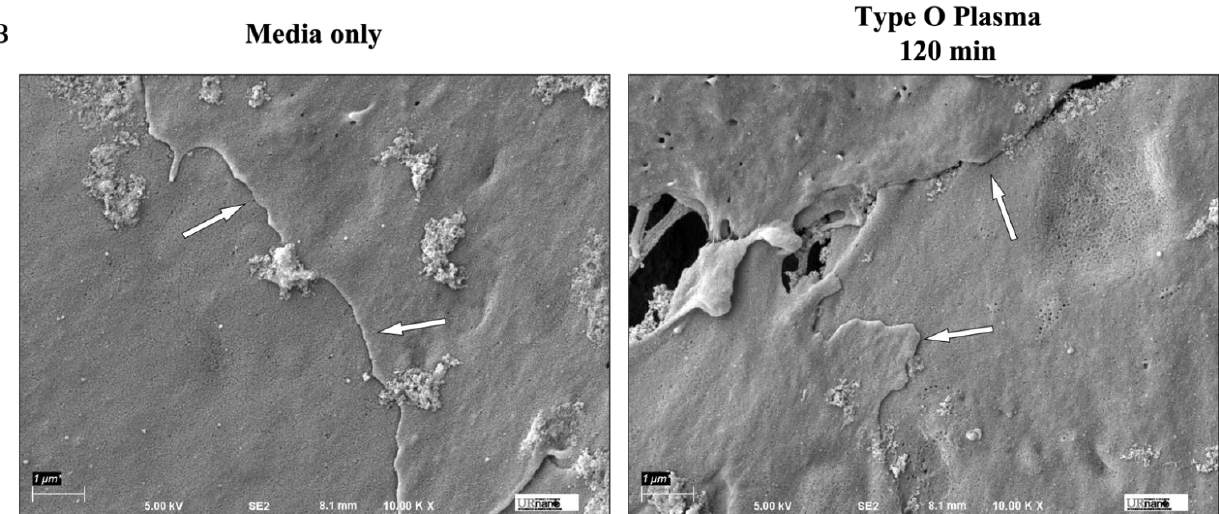
Figure 3. HPAEC cell–cell adhesion damaged by IC treatment. Type O HPAEC visualized by Scanning Electron Microscopy (SEM) after injury. ( A ) Cells were treated with non-concentrated or concentrated plasma-derived IC at 1:1 concentration with media for the indicated time points and imaged at different magnifications. Scale bar: 10,000 × : 1 µ m; 5000 × : 2 µ m; 1500 × : 7 µ m; 500 × : 20 µ m. ( B ) Cells were treated with type O plasma for 120 min and imaged at 10,000 × as a negative control for the effects of ABO identical plasma. Arrows denote cell–cell contact